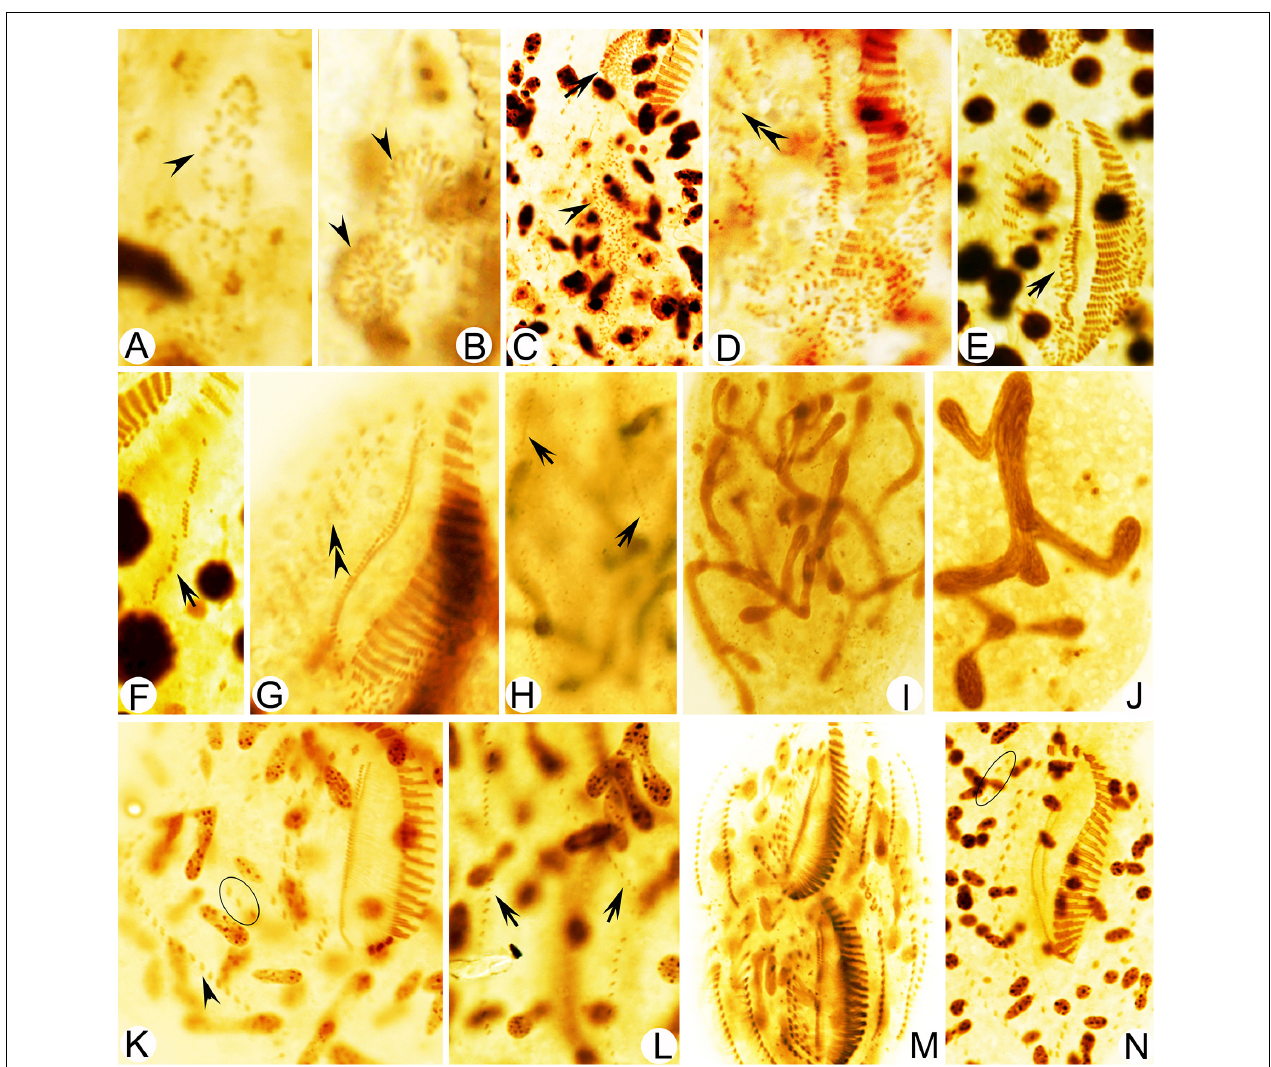
FIGURE 5 | Photomicrographs of Metaurostylopsis alrasheidi n. sp. during morphogenesis after protargol impregnation. (A,B) Ventral view of a very early divider, arrowheads point to the oral primordium of the opisthe (A) and the proter (B) . (C) The oral primordium continues to grow by further proliferation for proter (arrow) and opisthe (arrowhead) at early stage. (D,E) Ventral views, to show the formation of streak-like frontoventral transverse cirral anlagen (double-arrowheads) and newly formed undulating membrane anlagen (arrow) at early-middle stage. (F,G) Ventral views of middle dividers, to show the intrakinetally formed left marginal anlagen (arrow) and the newly developed cirri (double-arrowhead) formed from the frontoventral transverse cirral anlagen. (H) Dorsal view to show the dorsal kinety anlagen (arrows). (I,J) Macronuclear nodules fusing into a branching mass. (K) Ventral view of a late divider to show the newly formed right marginal cirri (arrowhead) and frontoterminal cirri (circle). (L) Dorsal view to show the new dorsal kineties, no caudal cirri are formed. (M,N) Ventral views of very late dividers, to show the immigration of frontoterminal cirri (circle). Scale bars = 50 µ m.